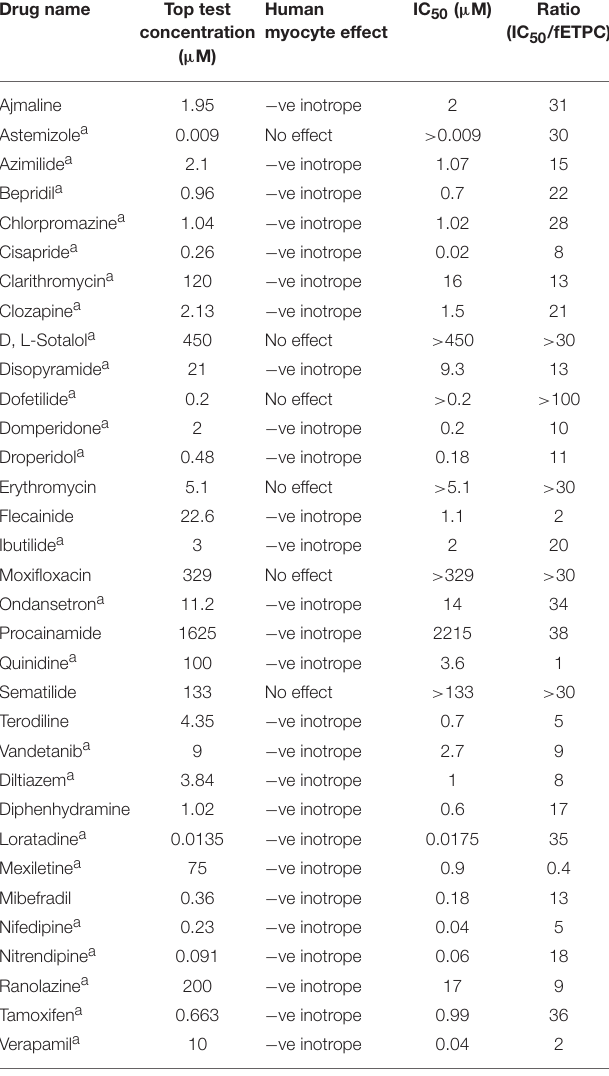
TABLE 5 | Sarcomere shortening effects for reference drugs measured in adult human primary cardiomyocytes. Drug